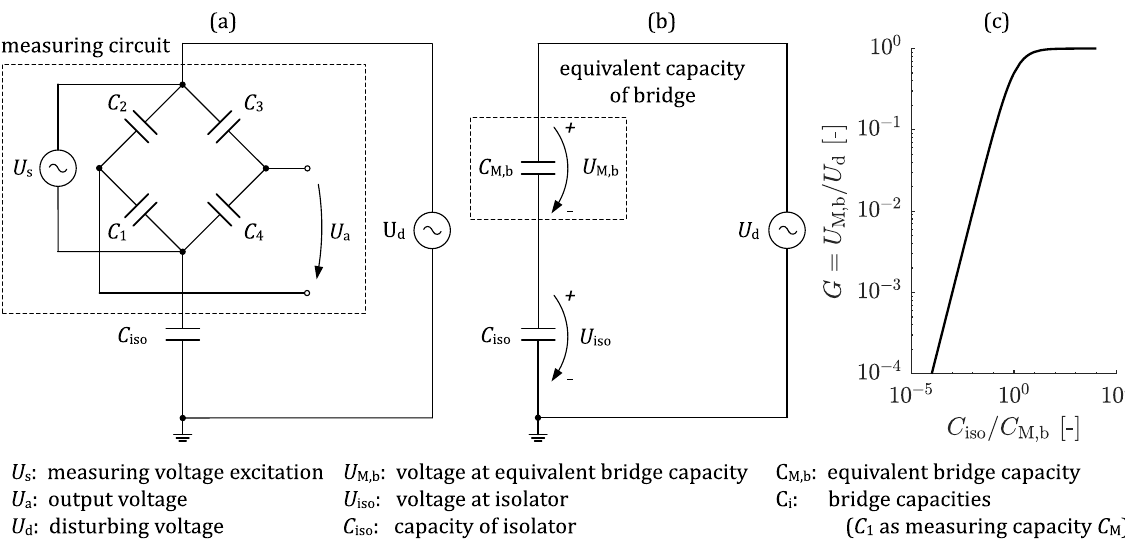
Figure 5. Schematic representation of a capacitive measuring circuit, interconnected to the electrical system of a machine tool: ( a ) capacitive displacement setup with primary evaluation based on a capacitive bridge; ( b ) equivalent circuit with condensed bridge capacity C M,b ; and ( c ) transfer function G in dependence of capacity ratio C iso / C M,b